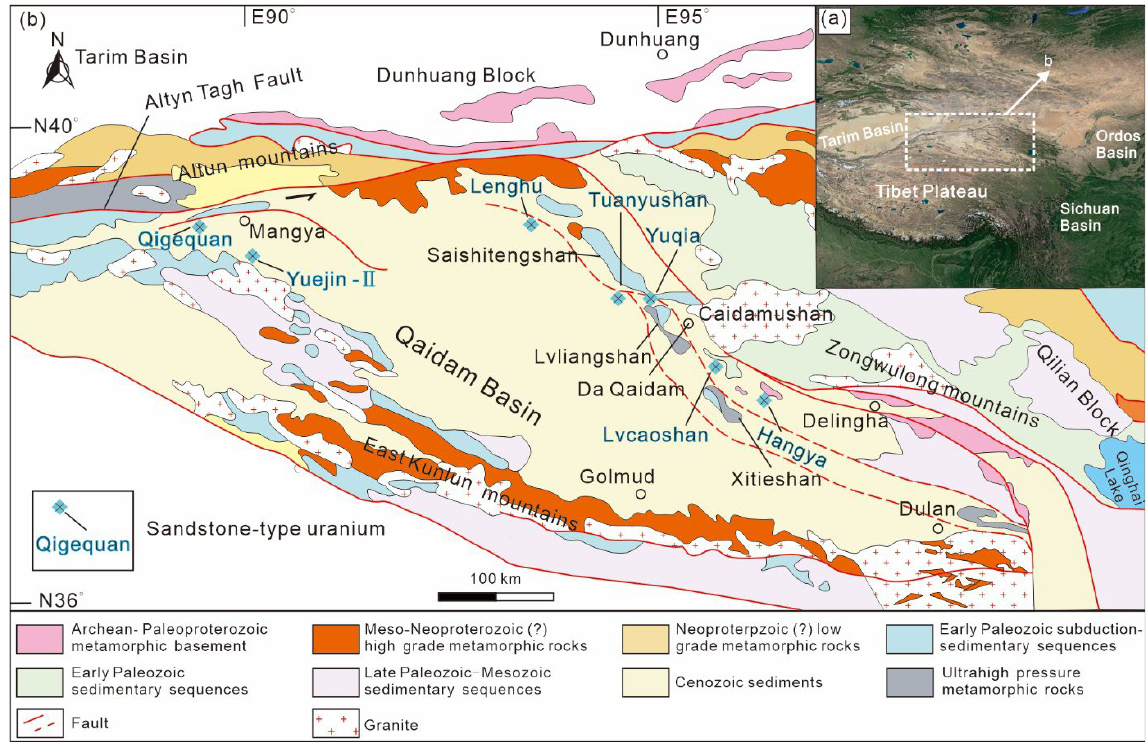
Figure 1. ( a ) Satellite map showing the location of the Qaidam Basin and ( b ) geological sketch map of the Altun-Qilian-Kunlun (AQK) orogenic system in the northern Tibet (modified after [32,33]).